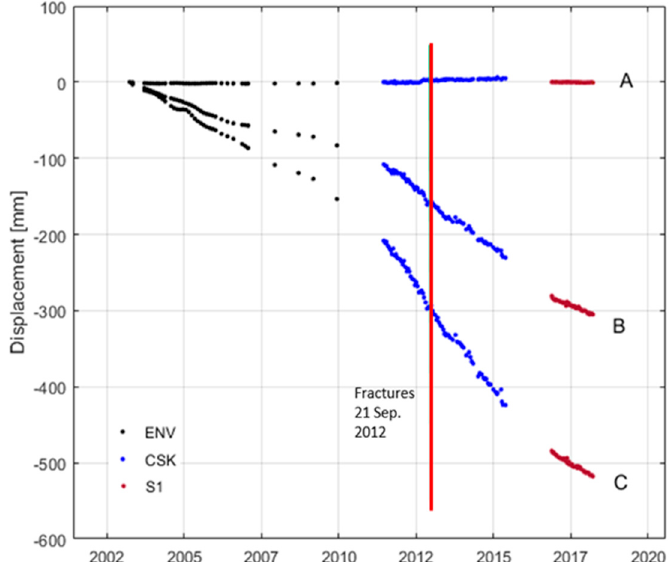
Figure 8. Example of three deformation trends in the ( A ), ( B ) and ( C ) sites of Figure 4. The displacements were estimated by ENV, CSK and S1 datasets (from ascending orbit only). The ENV and S1 displacement data are projected along the LOS CSK . Each of the three colors (black, blue and red) represents the three satellite-derived displacement measures. The A displacement points are relative to the part of the CG that lies on the bedrock and thus shows a stable behavior. The B displacement points are relative to a site located in correspondence of the cracks that opened on September 2012 (indicated by the green line). The C displacement points are relative to the northwestern part of CG, with high deformation